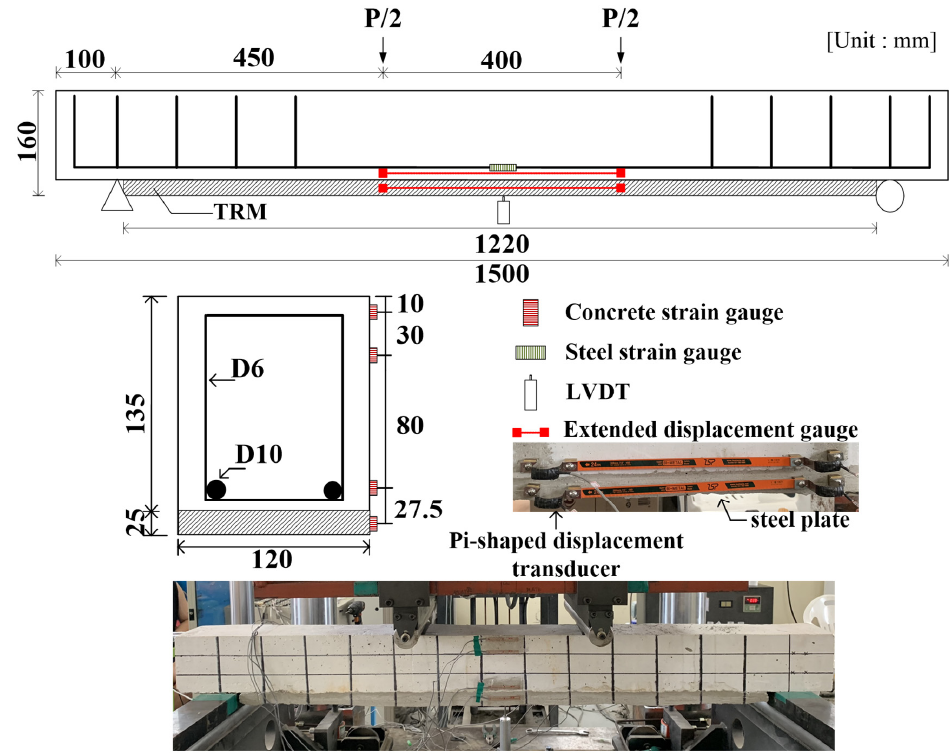
Figure 1. Schematic of specimen and test setup.